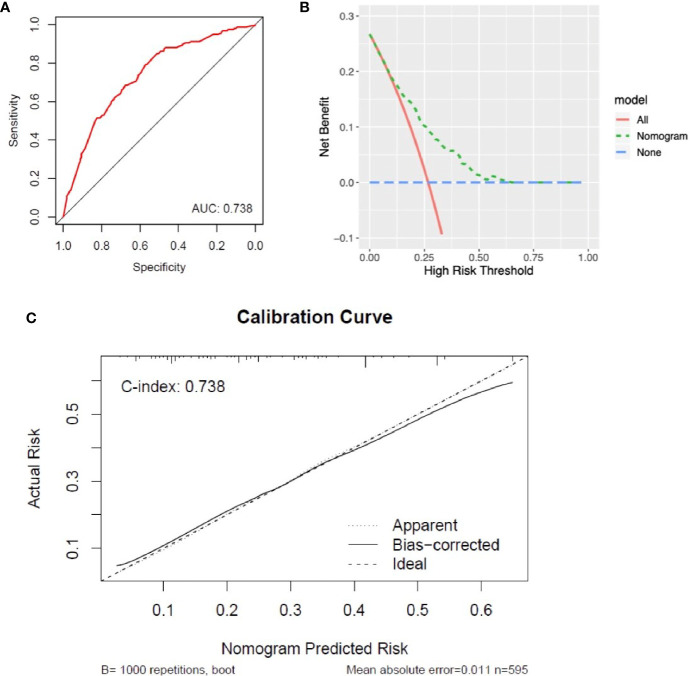
Assessment of the performance of nomogram in the SEER cohort. (A) The AUC was 0.73 (95% CI: 0.69–0.78) for ED in patients with localized NPC. (B) DCA for the nomogram in predicting ED. (C) Calibration curve of nomogram-predicted ED risk and actual risk.